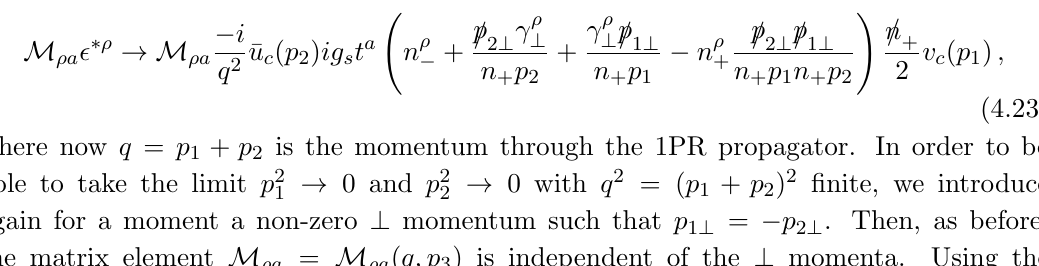
Figure 13 . 1PI diagrams contributing to the mixing J B 2 in the collinear sector with fermion number F i =